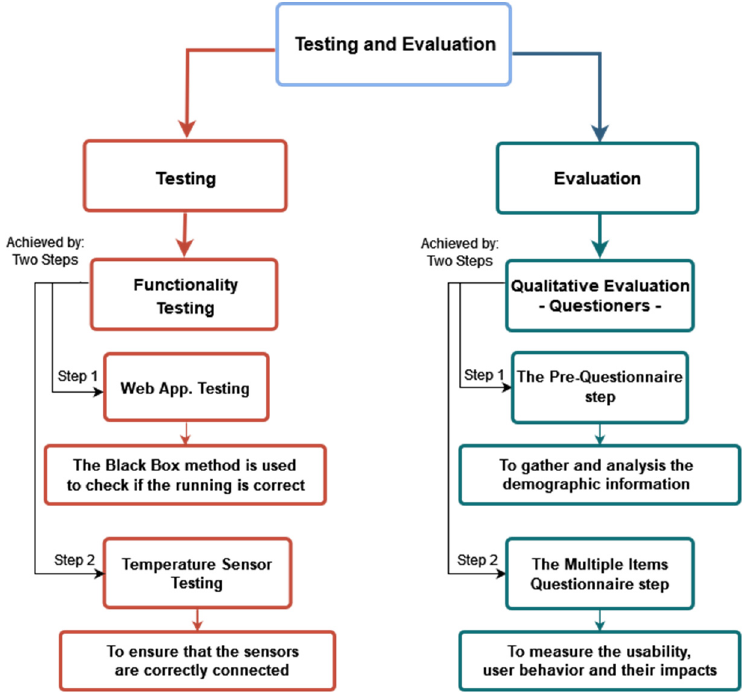
Figure 13. Testing and evaluation step. Table 3. Functional system requirement checked by black box